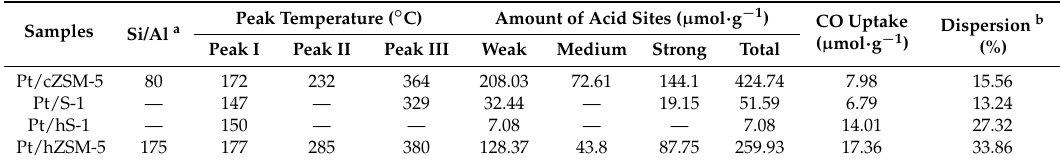
Figure 4. FE-TEM images and Pt particle size distributions of ( a ) Pt/S-1 ( b ) Pt/hS-1, ( c ) Pt/hZSM-5, and ( d ) Pt/cZSM-5 catalysts. Table 2. Acidity properties and CO chemisorption of various Pt catalysts.